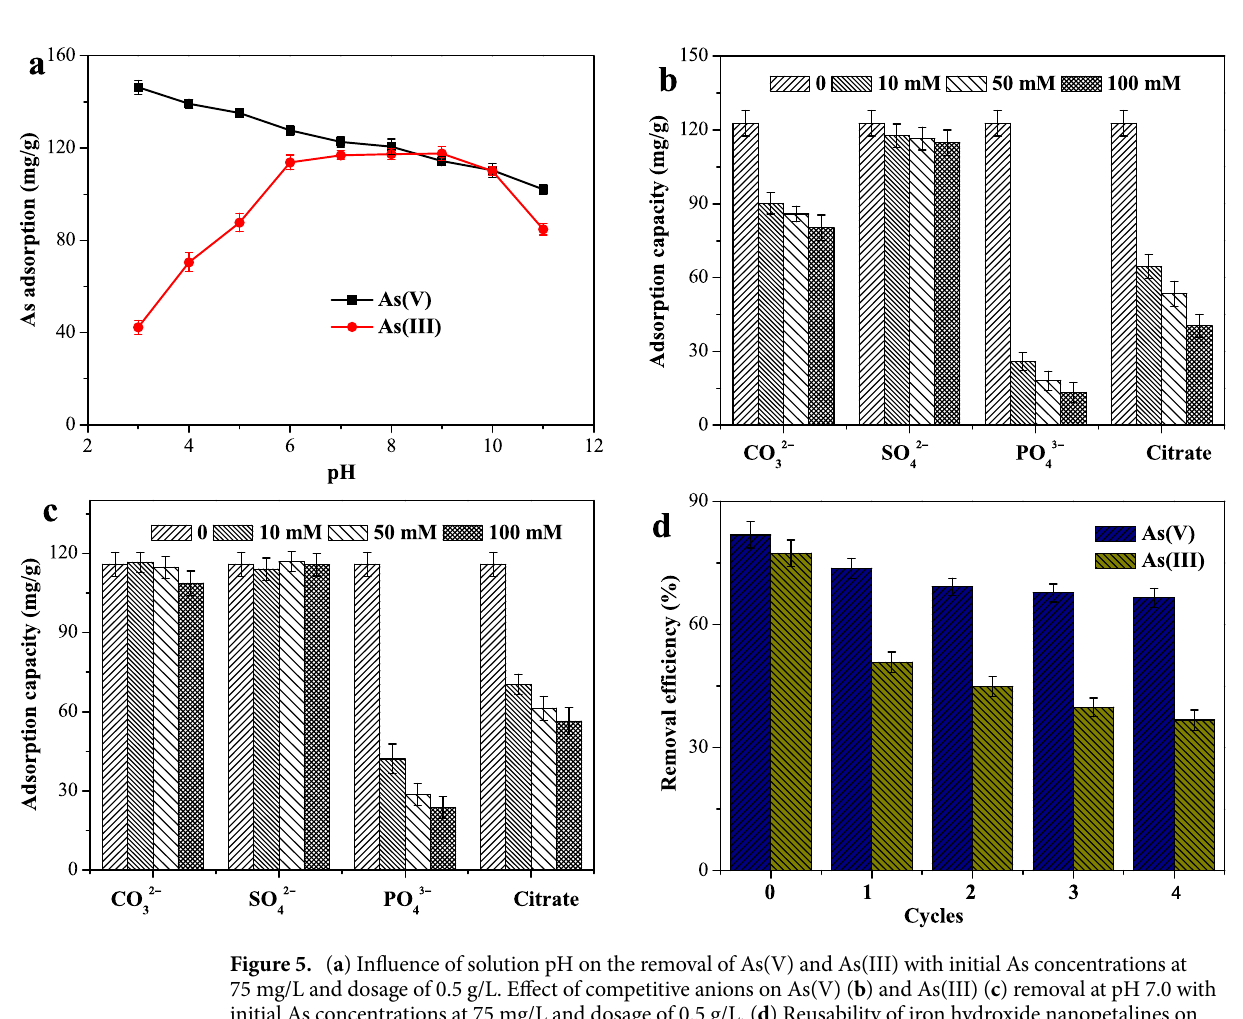
Figure 5. ( a ) Influence of solution pH on the removal of As(V) and As(III) with initial As concentrations at 75 mg/L and dosage of 0.5 g/L. Effect of competitive anions on As(V) ( b ) and As(III) ( c ) removal at pH 7.0 with initial As concentrations at 75 mg/L and dosage of 0.5 g/L. ( d ) Reusability of iron hydroxide nanopetalines on the removal of As(V) and As(III) with initial As concentrations at 75 mg/L and dosage of 0.5